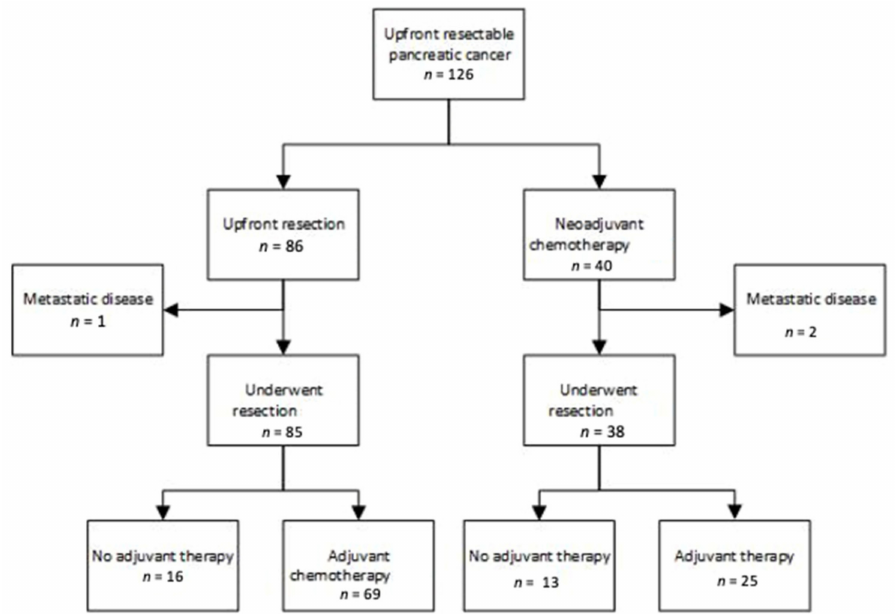
Figure 1. Treatment pathways for patients diagnosed with resectable pancreatic cancer.